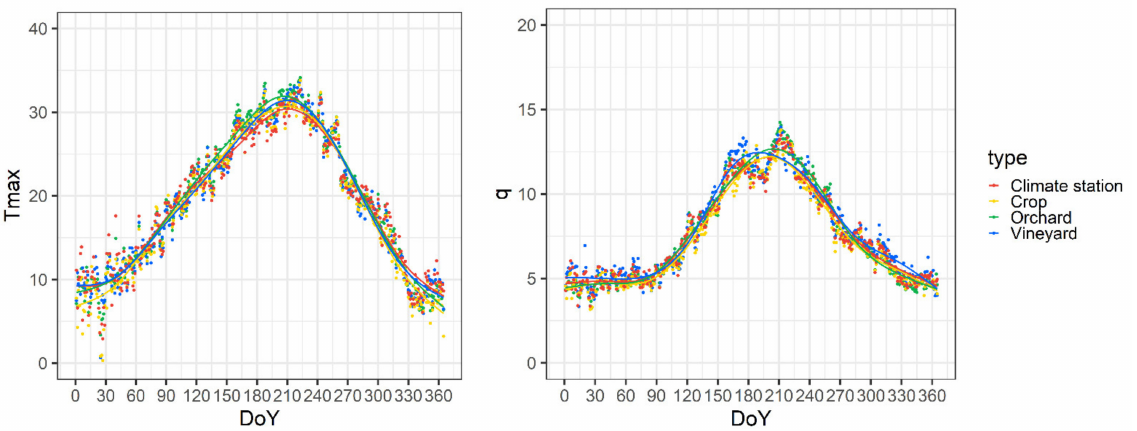
Figure 1. Regional average of maximum air temperature ( T max ( ◦ C)) and specific humidity ( q (g kg − 1 )) in orchards and crop canopies and at climate station Rimski Sancevi (grass) during the 2014–2020